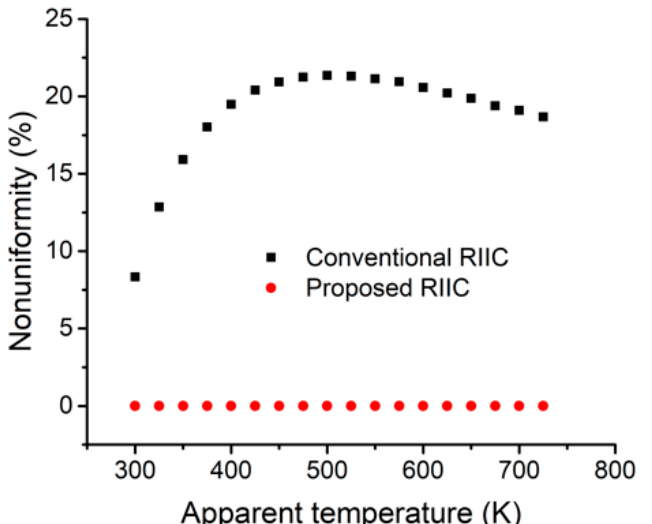
Figure 10. Nonuniformity comparison of IR emitter driven by the conventional and proposed RIICs.